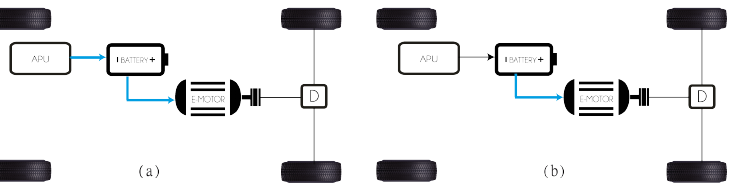
Figure 1. Configuration of an EREV and energy flow: ( a ) charge sustaining period; ( b ) depleting